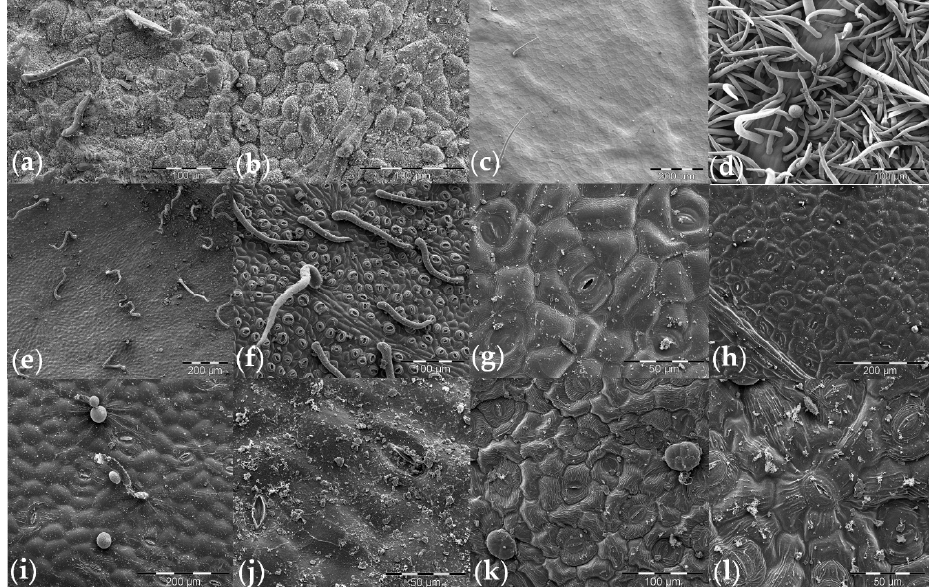
Figure 4. Prominent leaf micromorphological features of six highest dust collecting plant species: ( a ) M. oleifera —Ad; ( b ) M. oleifera —Ab; ( c ) O. paniculosa —Ad; ( d ) O. paniculosa —Ab; ( e ) P. guajava —Ad; ( f ) P. guajava —Ab; ( g ) C. roseus —Ad; ( h ) C. roseus —Ab; ( i ) G. fruticosus —Ad; ( j ) G. fruticosus —Ab; ( k ) I. batatas —Ad; ( l ) I. batatas —Ab. Ad, adaxial and Ab, abaxial leaf surface. Trees are followed by